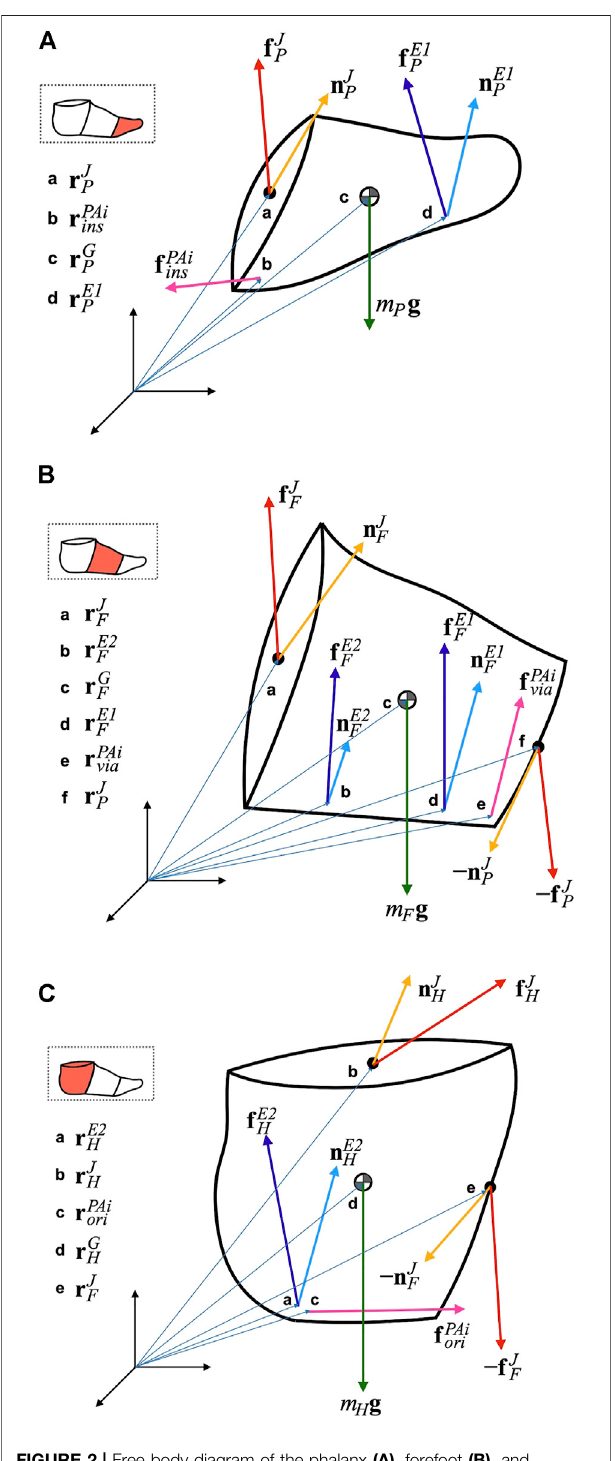
FIGURE 2 | Free body diagram of the phalanx (A) , forefoot (B) , and hindfoot segment (C) . See Table 2 for notations.